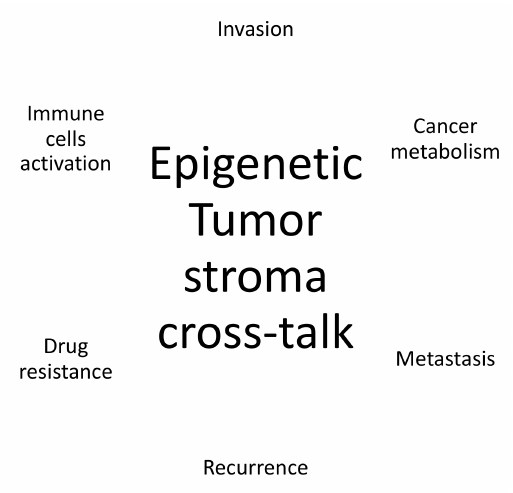
Figure 1. Mechanisms regulated by epigenetic tumour–stroma